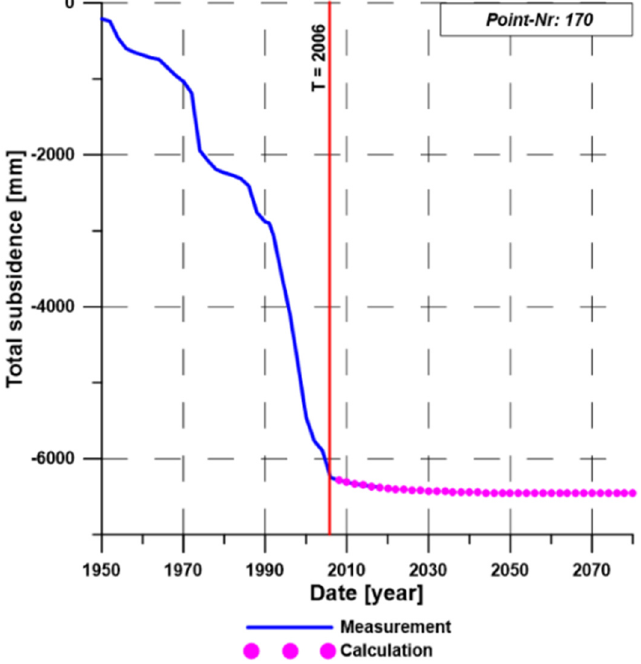
Figure 7. The course of subsidence until 2018 and the prediction of residual subsidence for the point no. 170.